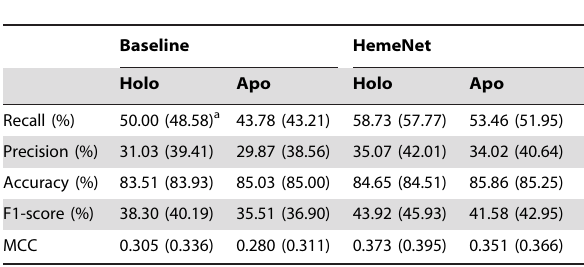
a The average measures of holo-apo protein pairs in Dataset 4.